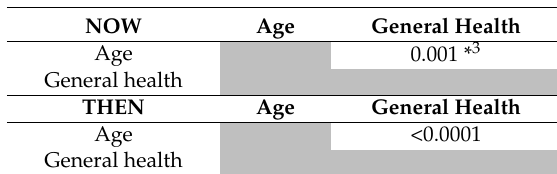
Table A2. Demographic 2.